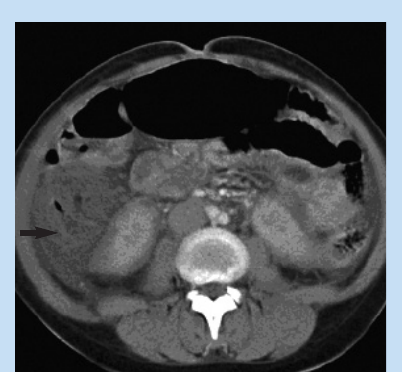
Fig.4.Contrast-enhanced CT scan at the level of the inferior poles of the kidneys demonstrates marked mural thickening (black arrow) of the ascending colon with pericolic inflammation.